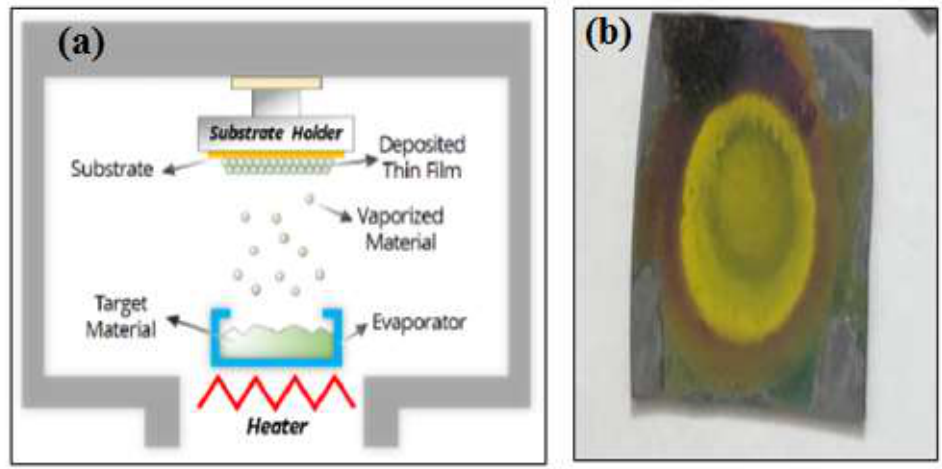
Figure 3 : (a): Scheme of thermal evaporation method, and (b): PbI 2 thin film on PSi substrate.